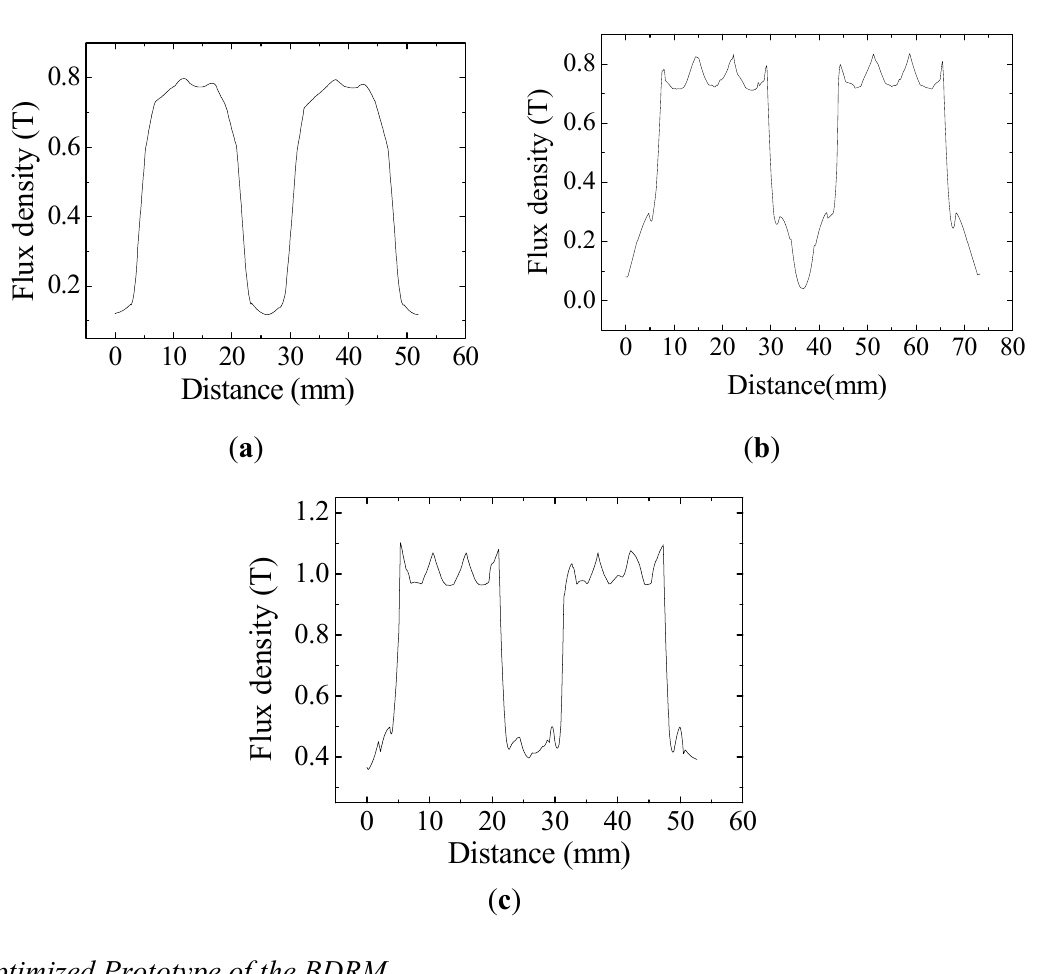
Figure 22. Inner air gap flux density: ( a ) Radial surface-mounted structure; ( b ) Radial embedding structure; ( c ) Tangential embedding